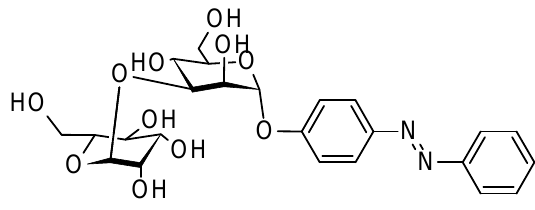
Figure 9. Azobenzene mannobioside.